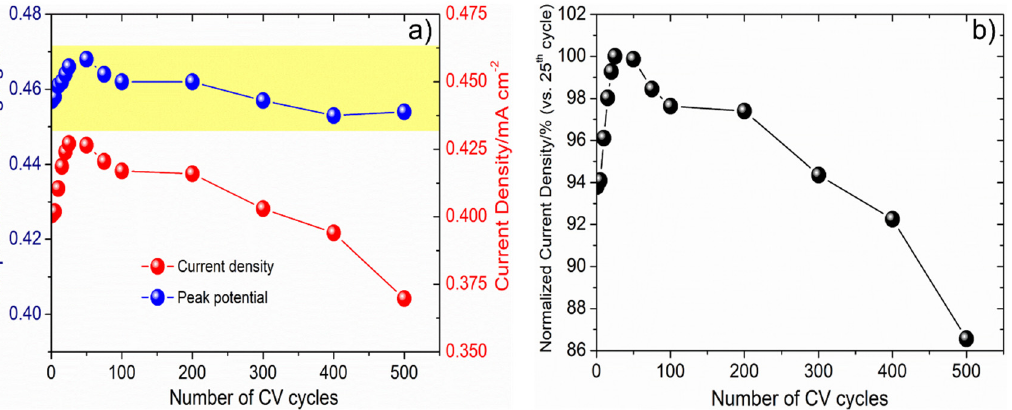
Figure 7. Graph depicting the stability of NPG_16h up to 500 CV cycles in terms of ( a ) the peak potential ( y -axis on the left) and current density at the peak potential ( y -axis on the right) and ( b ) peak current density of methanol electro-oxidation normalized with respect to the 25th cycle.